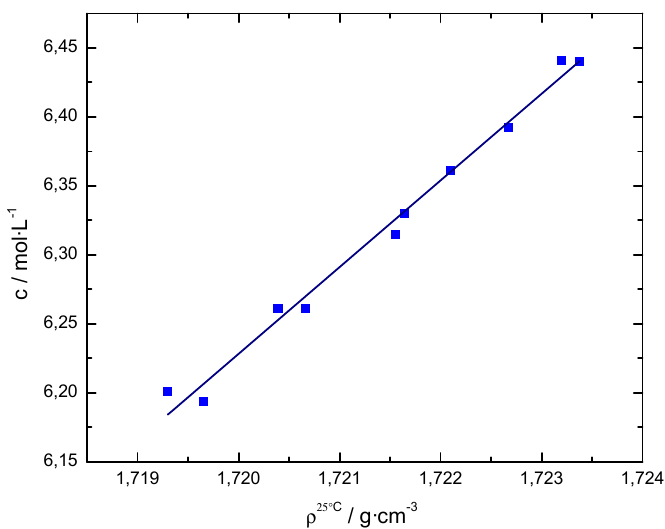
Figure 2. Concentration vs. density of LiAlCl 6.20–6.45 mol L − 1 .